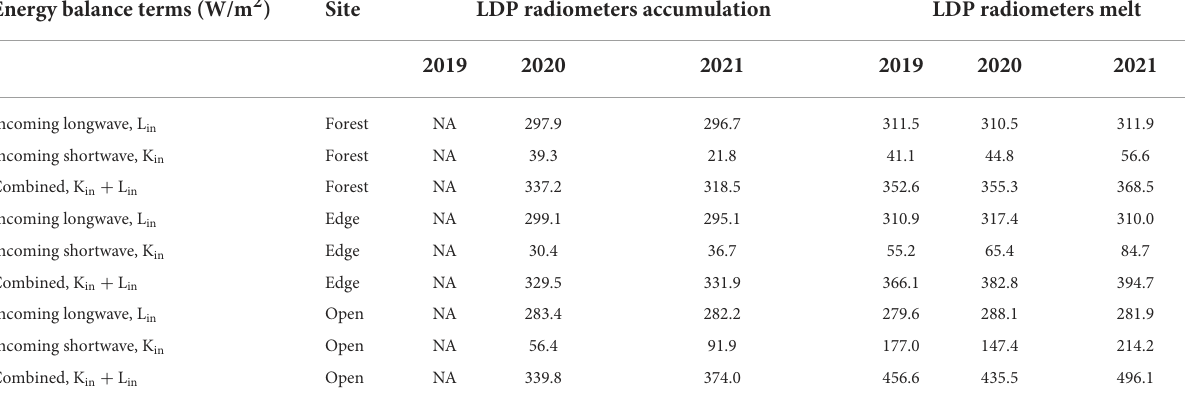
TABLE 3 Daily average measured incoming shortwave and longwave radiation at the LDP study site split into accumulation and melt periods.